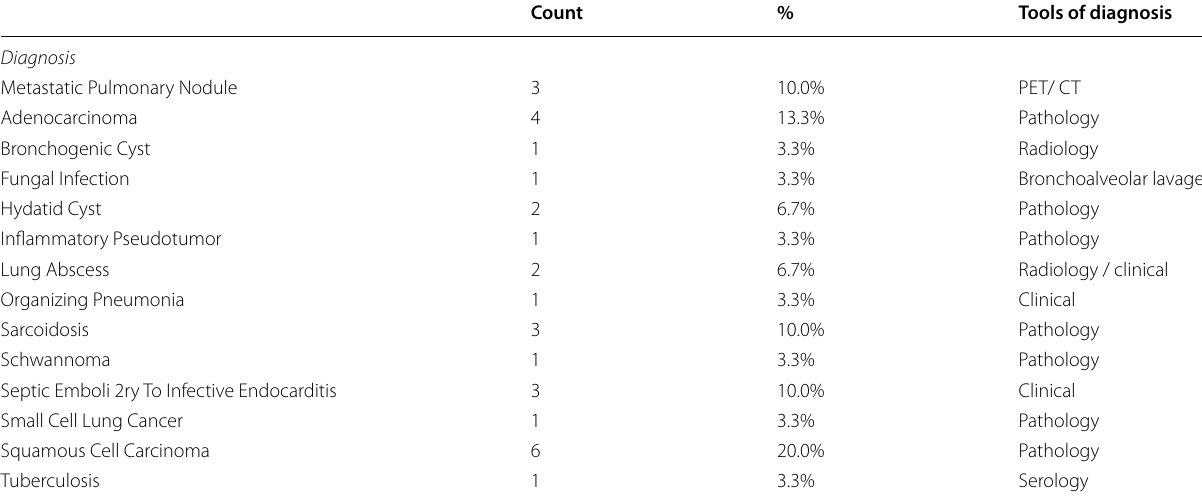
Table 1 Diagnosis of pulmonary lesions among the included patients and tool of